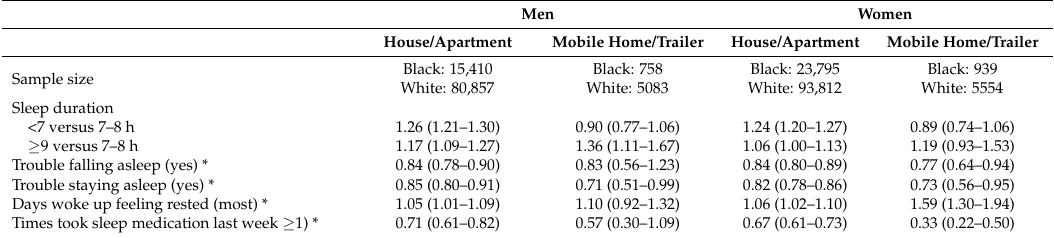
Table 3. Fully Adjusted Prevalence Ratios for Sleep Duration and Sleep Difficulties Compared to Housing Type among U.S. Black Men (referent White Men) and Black Women (referent White Women), National Health Interview Survey, 2004–2015 ( N =